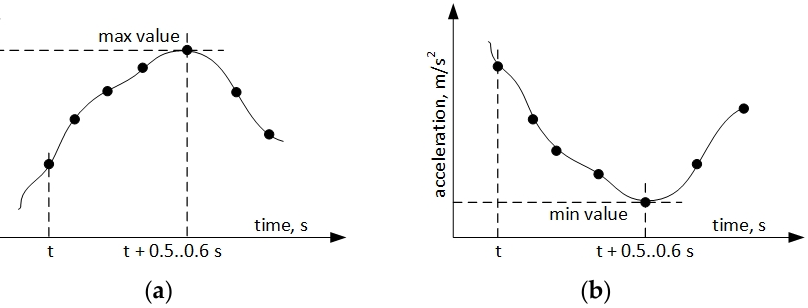
Figure 5. Diagrams of the method adopted to identify maneuvers and their extreme values: ( a ) ac- celeration, ( b ) braking. ( a ) acceleration, ( b )